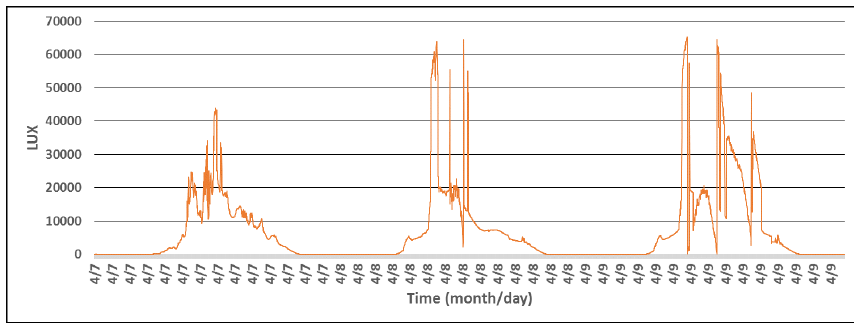
Figure 9. Light intensity measured by a T, RH, and LUX beacon during three days.